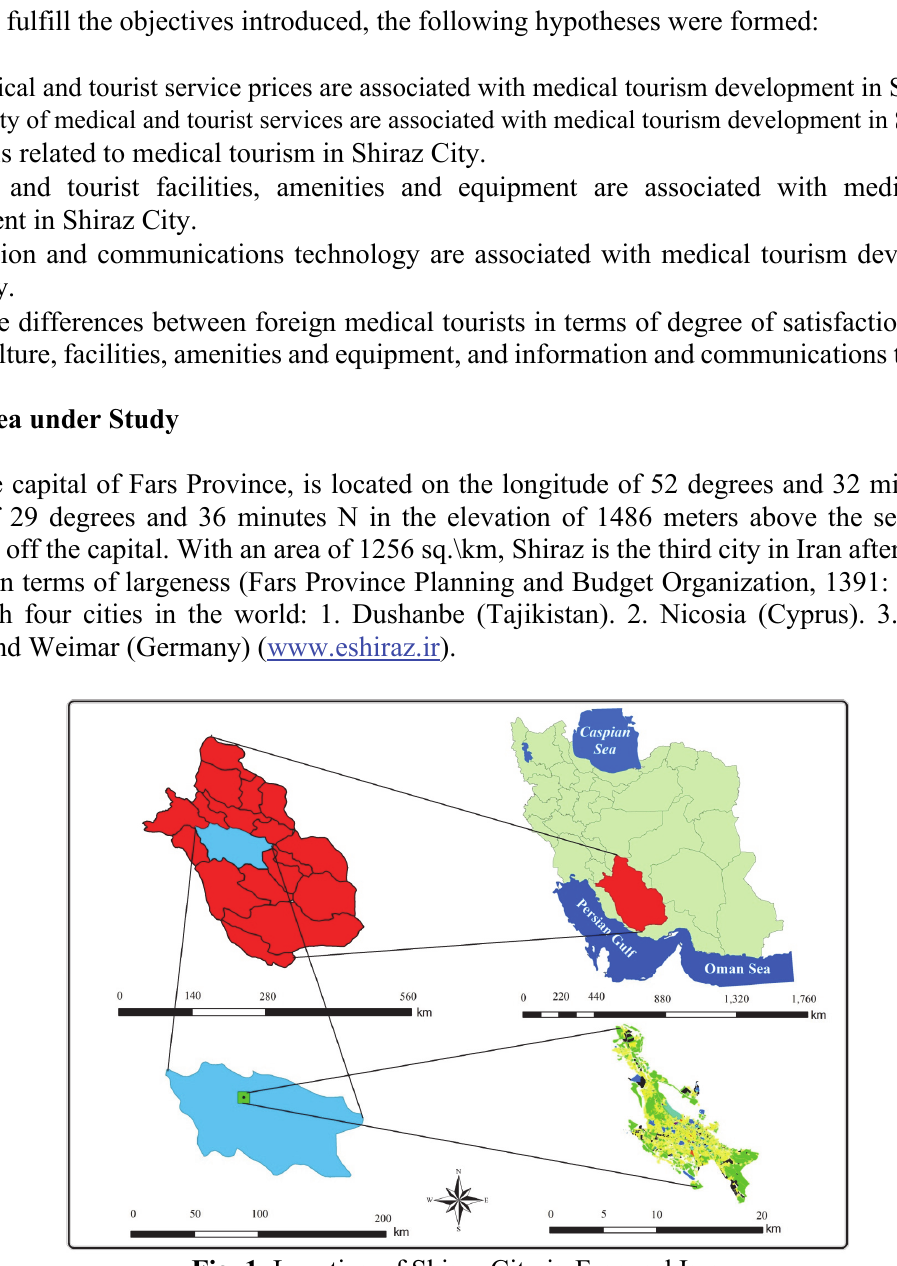
Fig. 1. Location of Shiraz City in Fars and